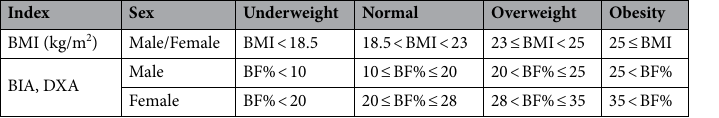
Table 3. Obesity class standard